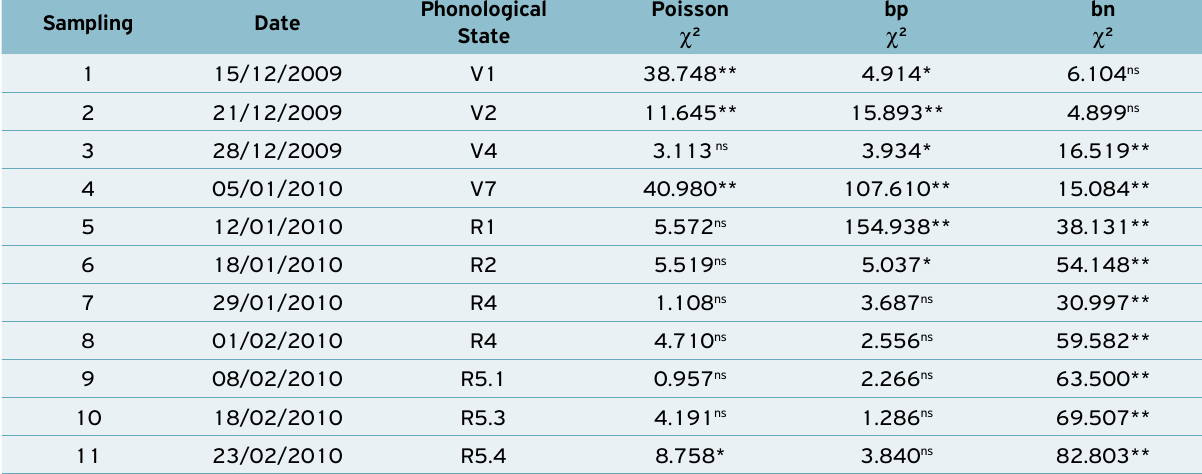
*indicates 5% probability; **indicates 1% probability; ns indicates non-significant 5%